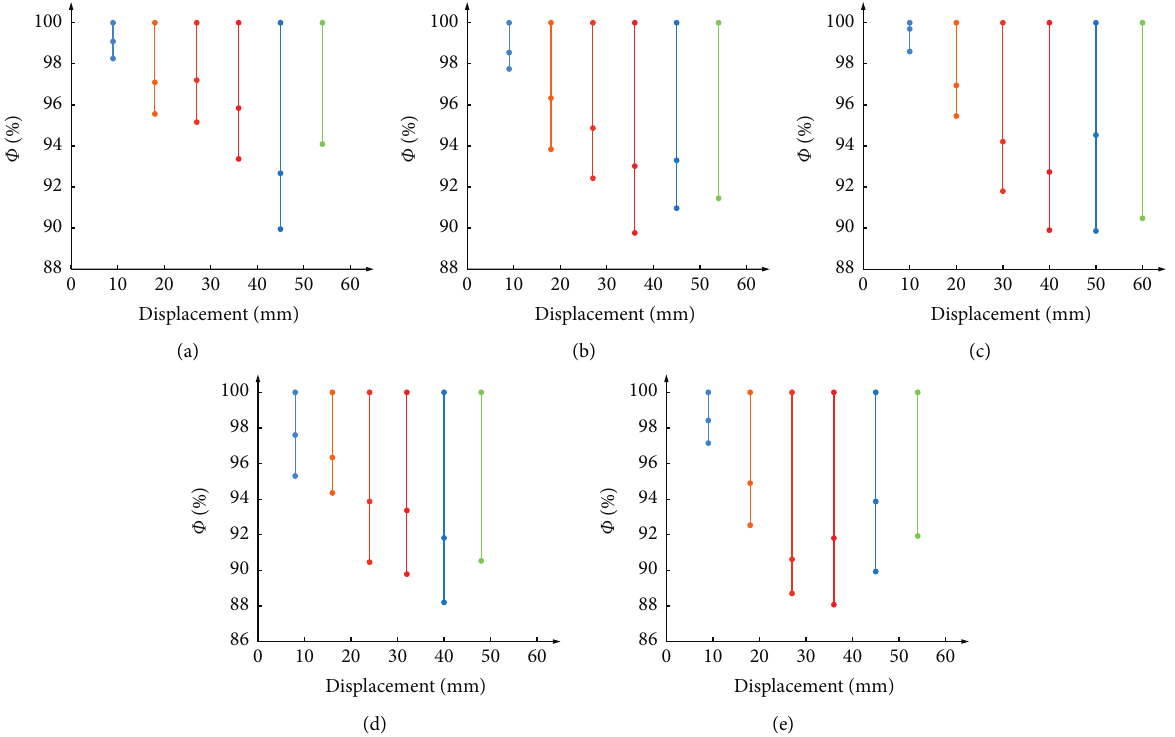
Figure 8: Strength attenuation of each specimen. (a) PTRC-1. (b) PURC-1. (c) PURC-2. (d) PURC-3. (e)